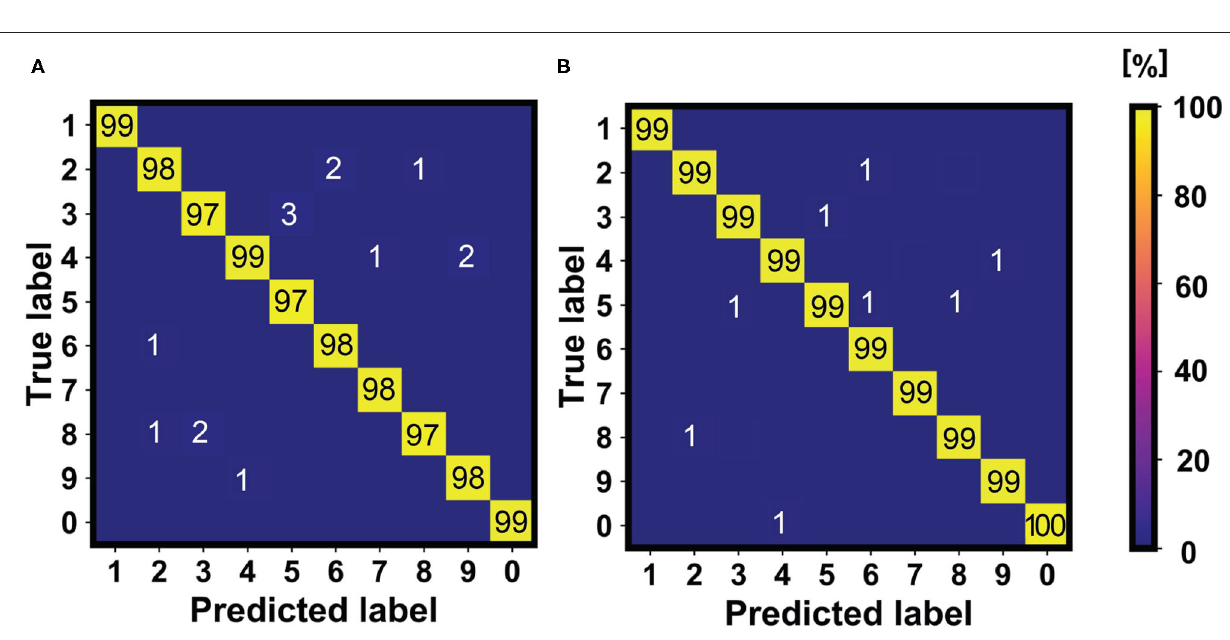
FIGURE 12 | Comparison of the accuracies of previous works (Muñoz-Martín et al., 2019) (A) with the accuracies obtainable after using homeostatic neurons in the last layer of the network (B) . Note that the accuracy results increase in the second case, which is mainly due to the improved specialization capability and to the active forgetting mechanism introduced by the SFA homeostatic